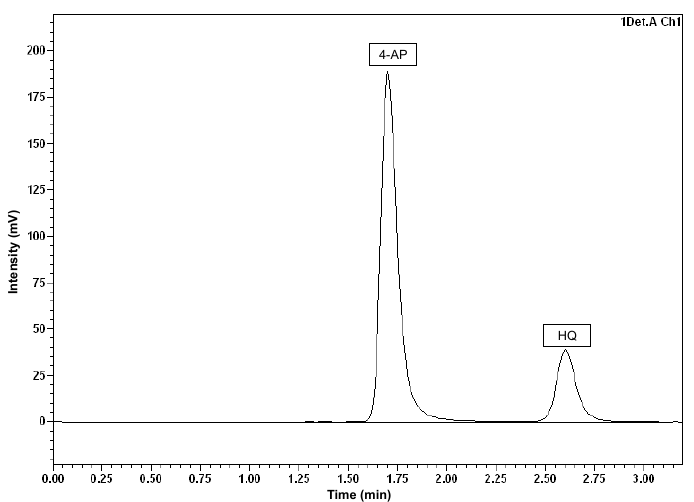
Figure 5. Chromatogram obtained by HPLC analysis illustrating the detection of the APAP biodegradation intermediates: 4-aminophenol (4-AP) and hydroquinone (HQ).